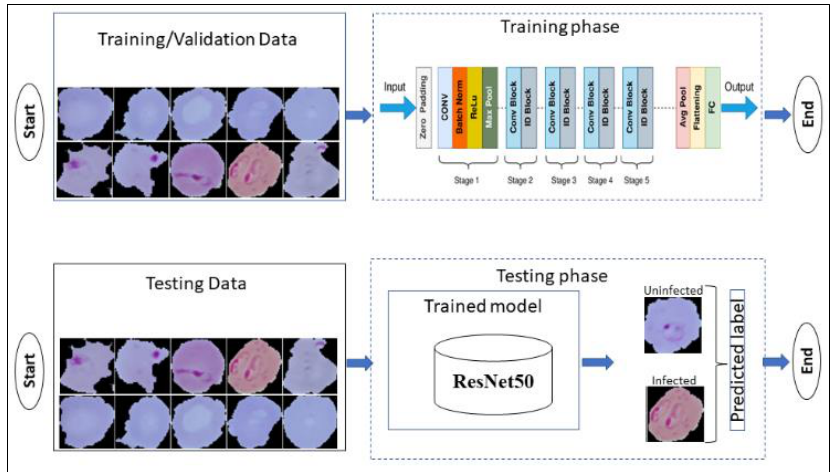
Figure 6. Block diagram of ResNet50 model.